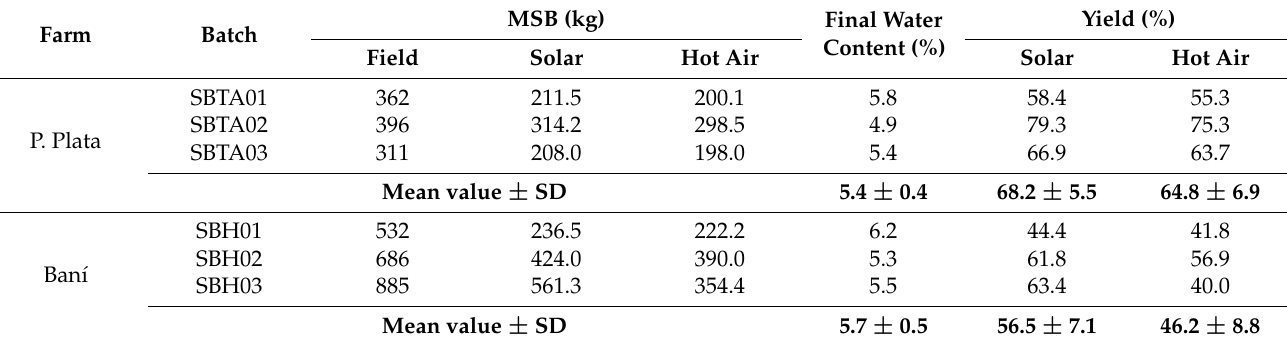
Figure 1. Pellets from mango and cocoa agricultural biowastes: ( 1 ) mango stem bark, ( 2 ) mango branch tree, ( 3 ) cocoa pod husk, ( 4 ) cocoa bean shell. Table 3. Yield of mango stem bark and water content after